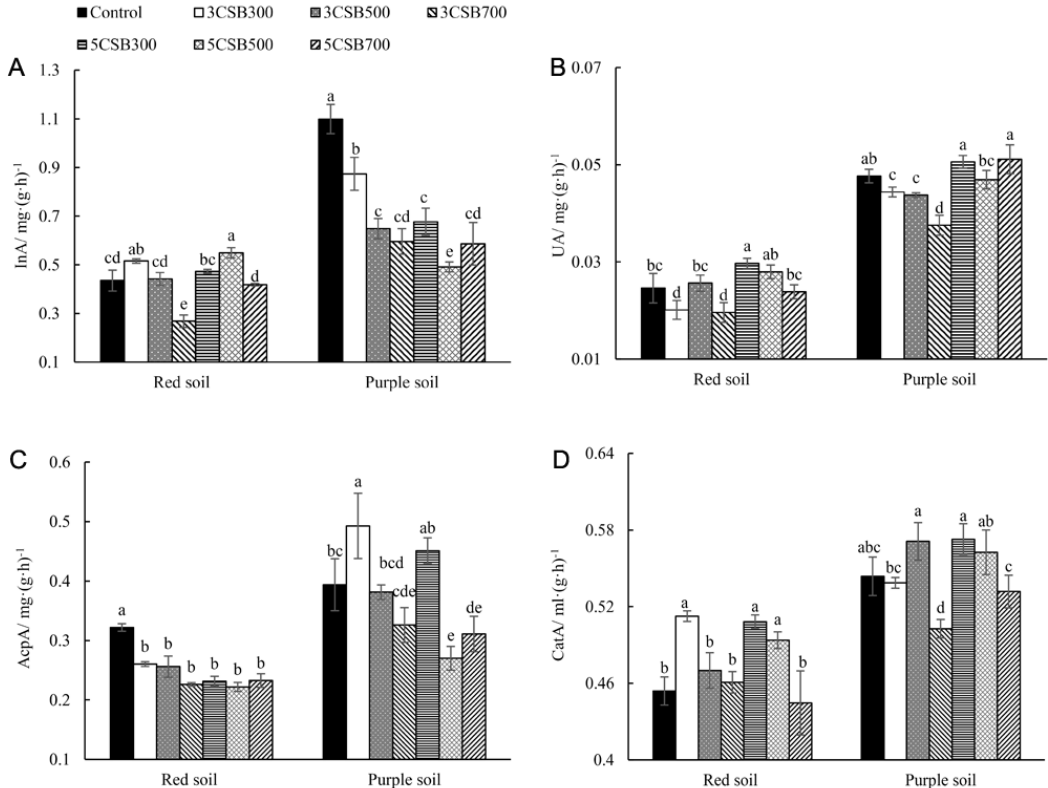
Figure 2. Soil enzyme activities in both soils after 180 days of incubation. The X -axis indicates different soil types, including red soil and purple soil. ( A ): InA activity in both soils after 180 days of incubation. ( B ): UA activity in both soils after 180 days of incubation. ( C ): AcPA activity in both soils after 180 days of incubation. ( D ): CatA activity in both soils after 180 days of incubation. Control: red / purple soil without biochar application; Abbreviation: InA: invertase activity, UA: urease activity, AcPA: acid phosphatase, CatA: catalase activity. Different lowercase letters within a line indicated significant Table 4. Three-way ANOVA for microbial properties in both soils. The table shows F ratios and P value for the three factors: soil type (ST), biochar pyrolysis temperature (BPT) and biochar application rate (BAR). Parameters E ff